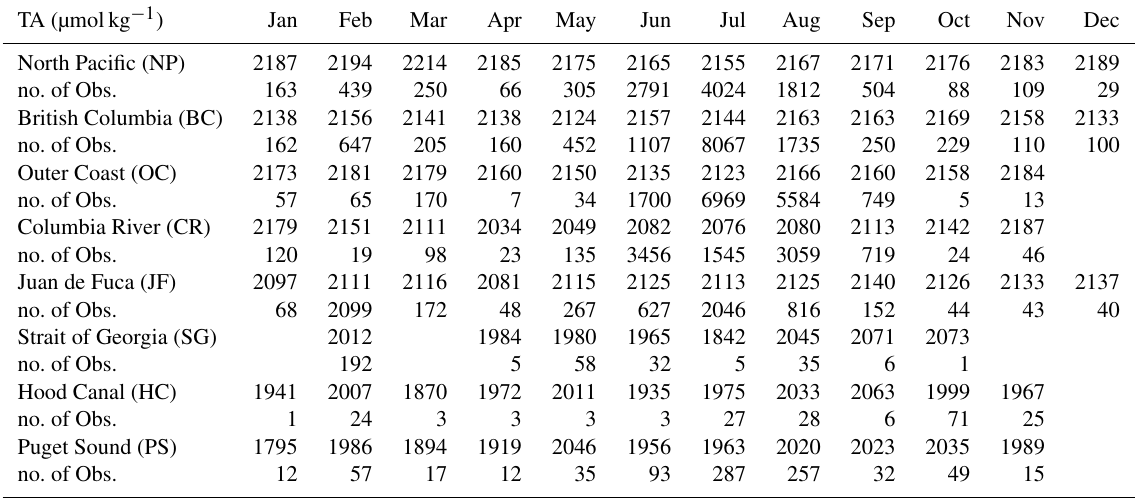
Table B3. Average monthly TA seasonal cycles for the eight unique regions. The total number of observations (no. of Obs.) contributing to the monthly average estimate is included.